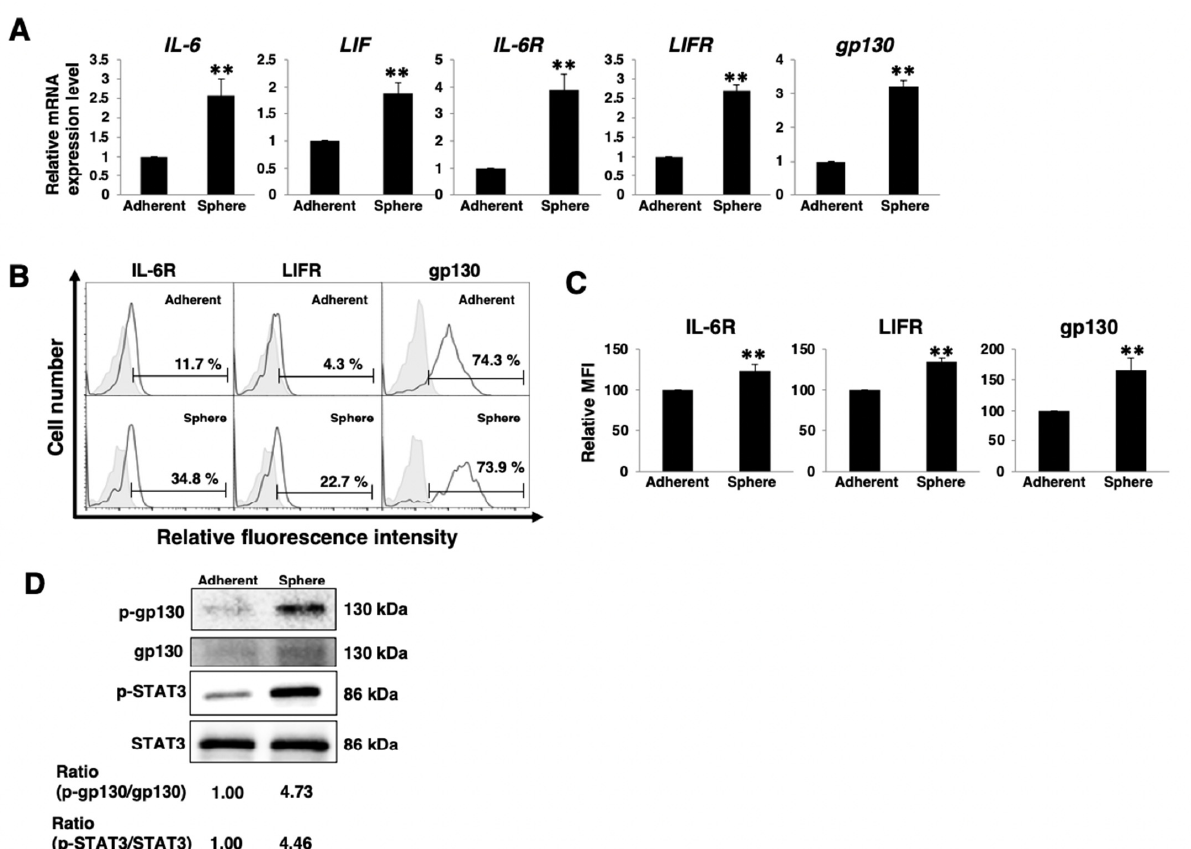
Figure 1. Active gp130/STAT3 pathway in PANC-1 sphere cells. ( A ) Real-time qPCR analysis of IL-6 , LIF , IL-6R , LIFR , and gp130 in PANC-1 cells cultured in 2D (adherent) or 3D (sphere) conditions. The results presented are normalized to values obtained for adherent cells (value = 1). Results are presented as means ± SD from three independent experiments. ( B ) FACS analysis of IL-6R, LIFR, and gp130 expression in PANC-1 cells cultured in 2D (adherent) or 3D (sphere) conditions. Controls are indicated by thin lines with gray color. ( C ) Cell surface levels of IL-6R, LIFR, and gp130 expression in PANC-1 cells cultured in 2D (adherent) or 3D (sphere) conditions. Mean fluorescence intensities (MFIs) relative to those of adherent cells are presented. Results are presented as means ± SD from three independent experiments. ( D ) Western blot analysis of p-gp130, gp130, p-STAT3, and STAT3 was performed in PANC-1 cells cultured in 2D (adherent) or 3D (sphere) conditions. Relative band intensity is provided. ** p <